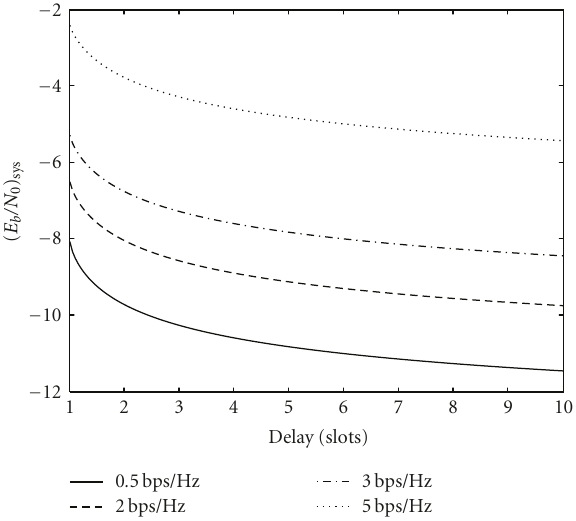
Figure 1: Total transmitted energy ( E b /N 0 )